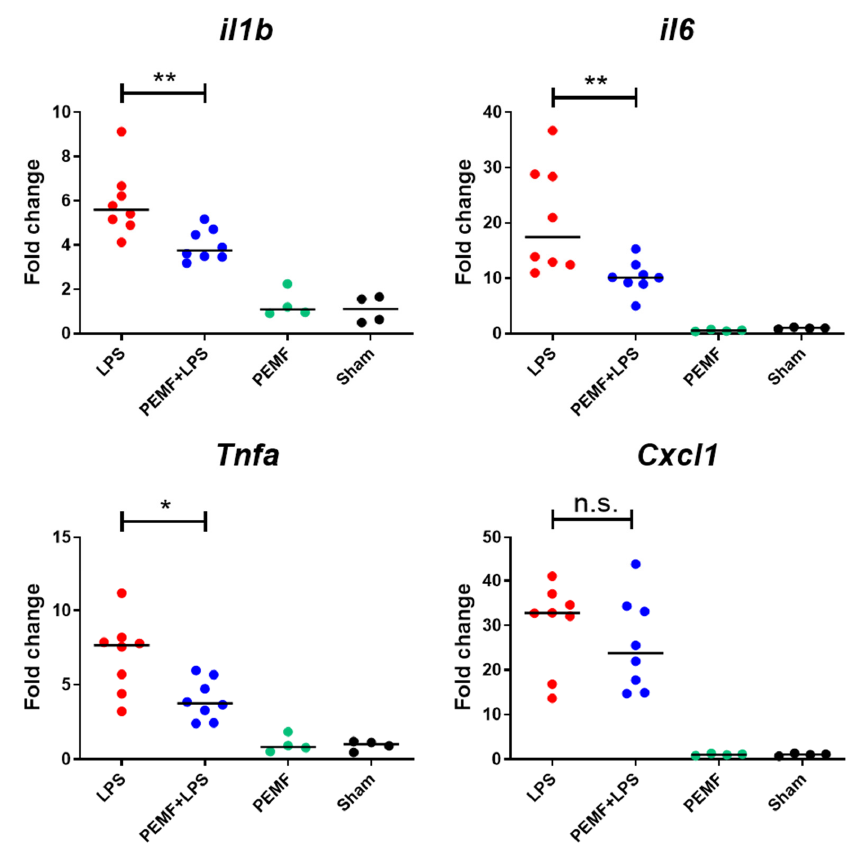
Figure 3. Effect of PEMF on cytokine mRNA expression in liver of septic shock-induced mice. Mice were injected with LPS (15 mg/kg) and exposed to PEMF treatment for 1 day. The mRNA expression levels of pro-inflammatory cytokines in the liver were analyzed by qRT-PCR. Relative gene expres- sion was normalized to mouse Gapdh expression. Mouse IL-1 β ( il1b ), IL-6 ( il6 ), TNF- α ( Tnfa ), and KC ( Cxcl1 ). * p < 0.05, ** p < 0.01 (Mann–Whitney test). Each dot represents one mouse. Bars indicate median. n.s., not significant.